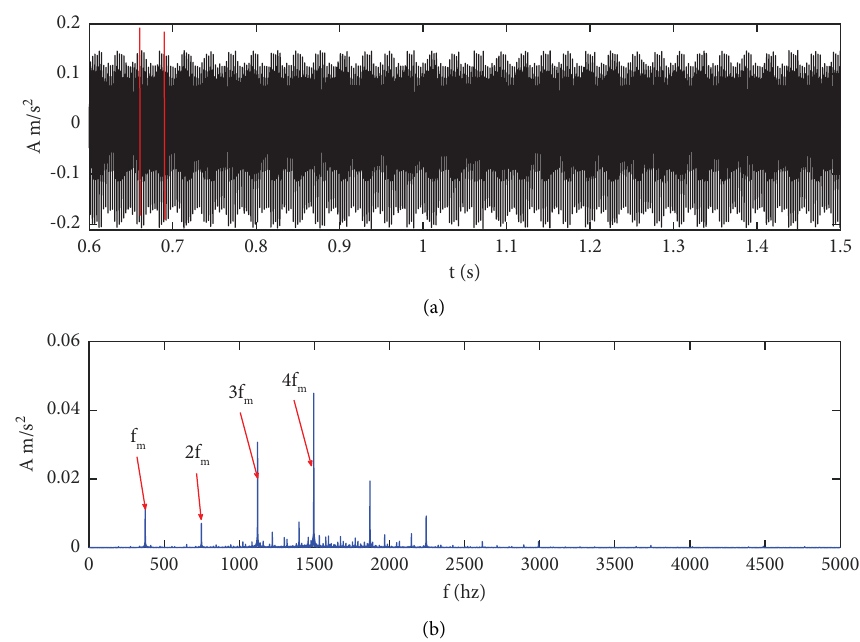
Figure 13: Responses of the driven gear node: (a) the time domain; (b) the frequency domain.